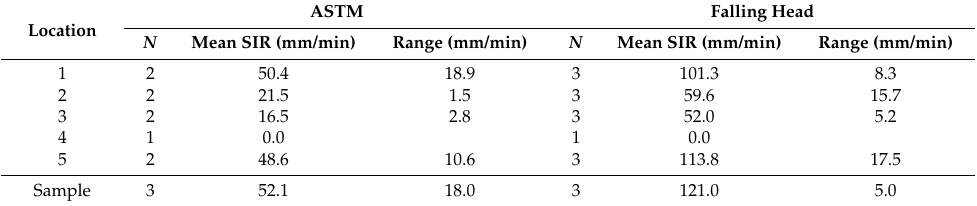
Table 3. Comparison of ASTM and falling head test in porous asphalt field site and the control sample. Data set size N (of the data leading to the mean SIR and range given) are provided for each location tested on the surface. The collection dates for locations 1–5 are 20 March to 31 March for the ASTM method and 27 April to 30 April for the falling head test. The data collected on the sample were taken